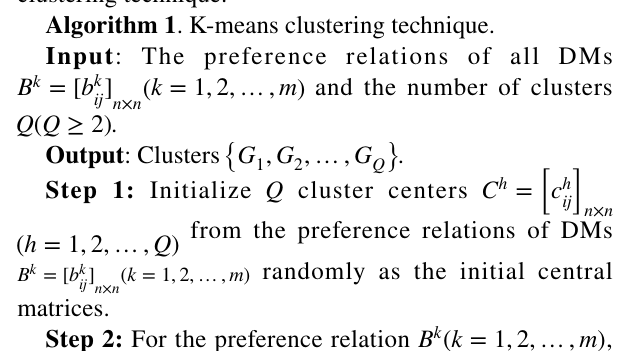
Algorithm 1 . K-means clustering